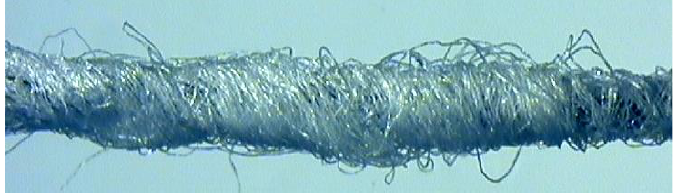
Figure 4. Exemplary microscopic picture of the OE cotton yarn.